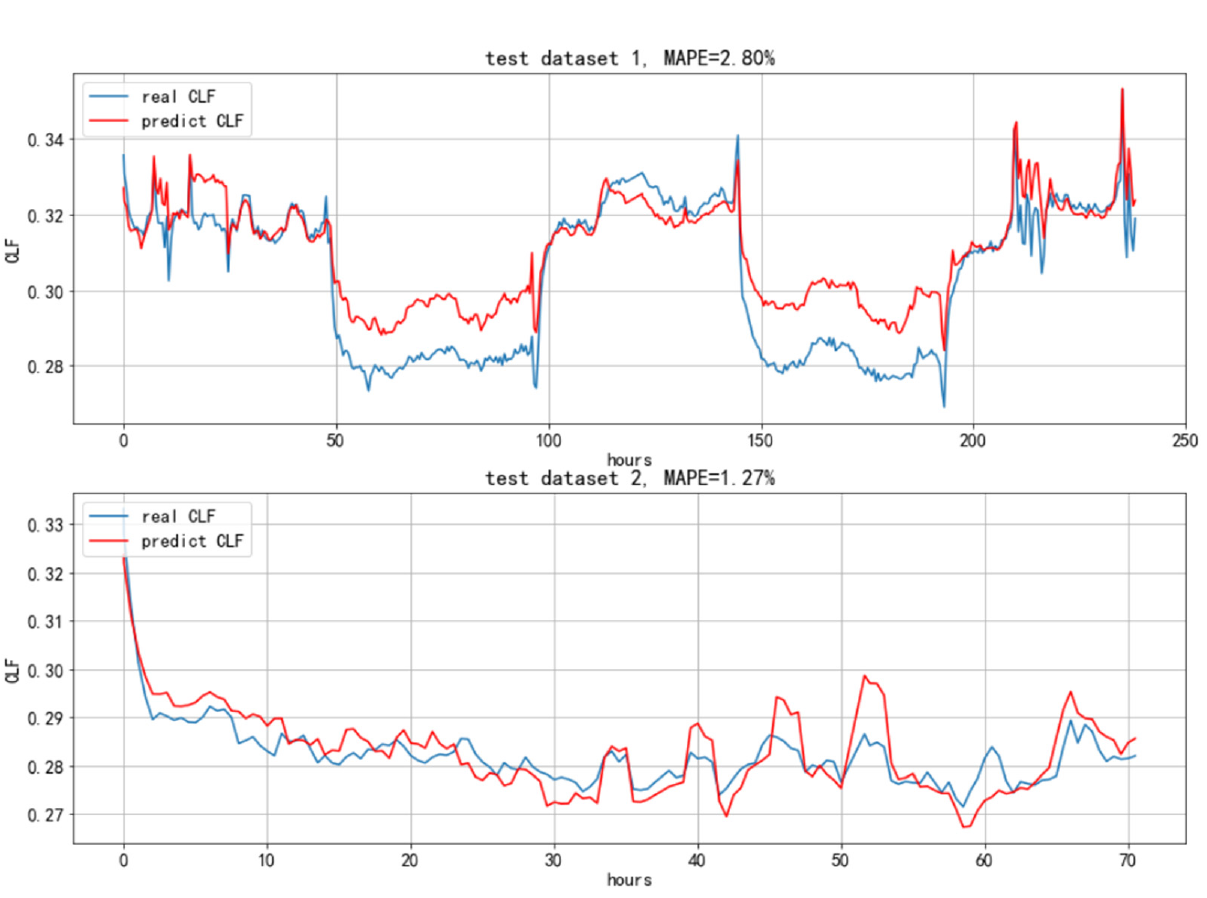
Figure 4. Test results of the surrogate model for objective function.